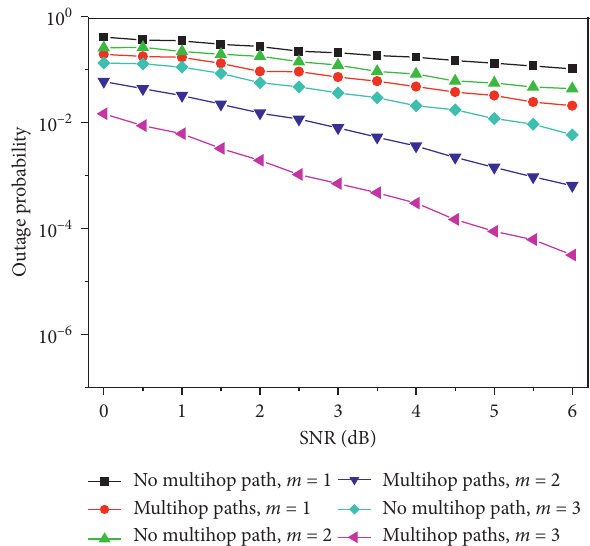
Figure 9: Comparison of outage probability results under the presence/absence of a multihop path of the system.